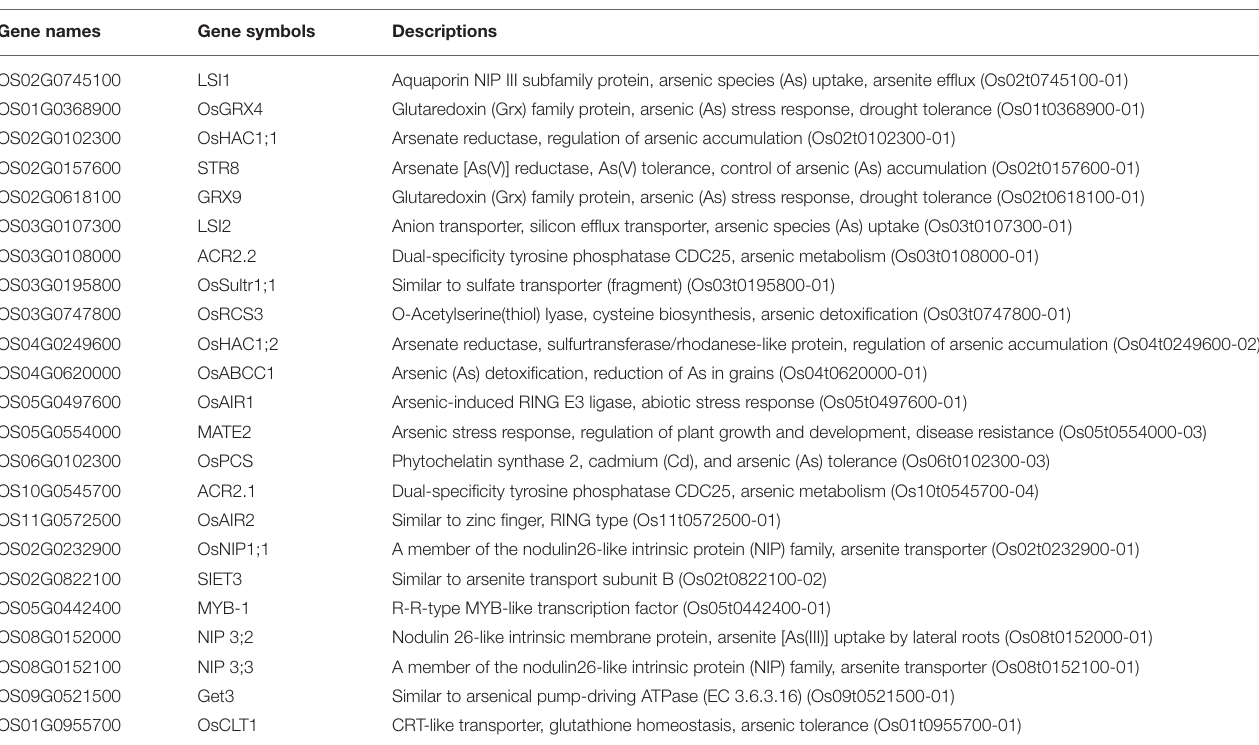
TABLE 1 | Genes involved in As transport, detoxification, or stress response in